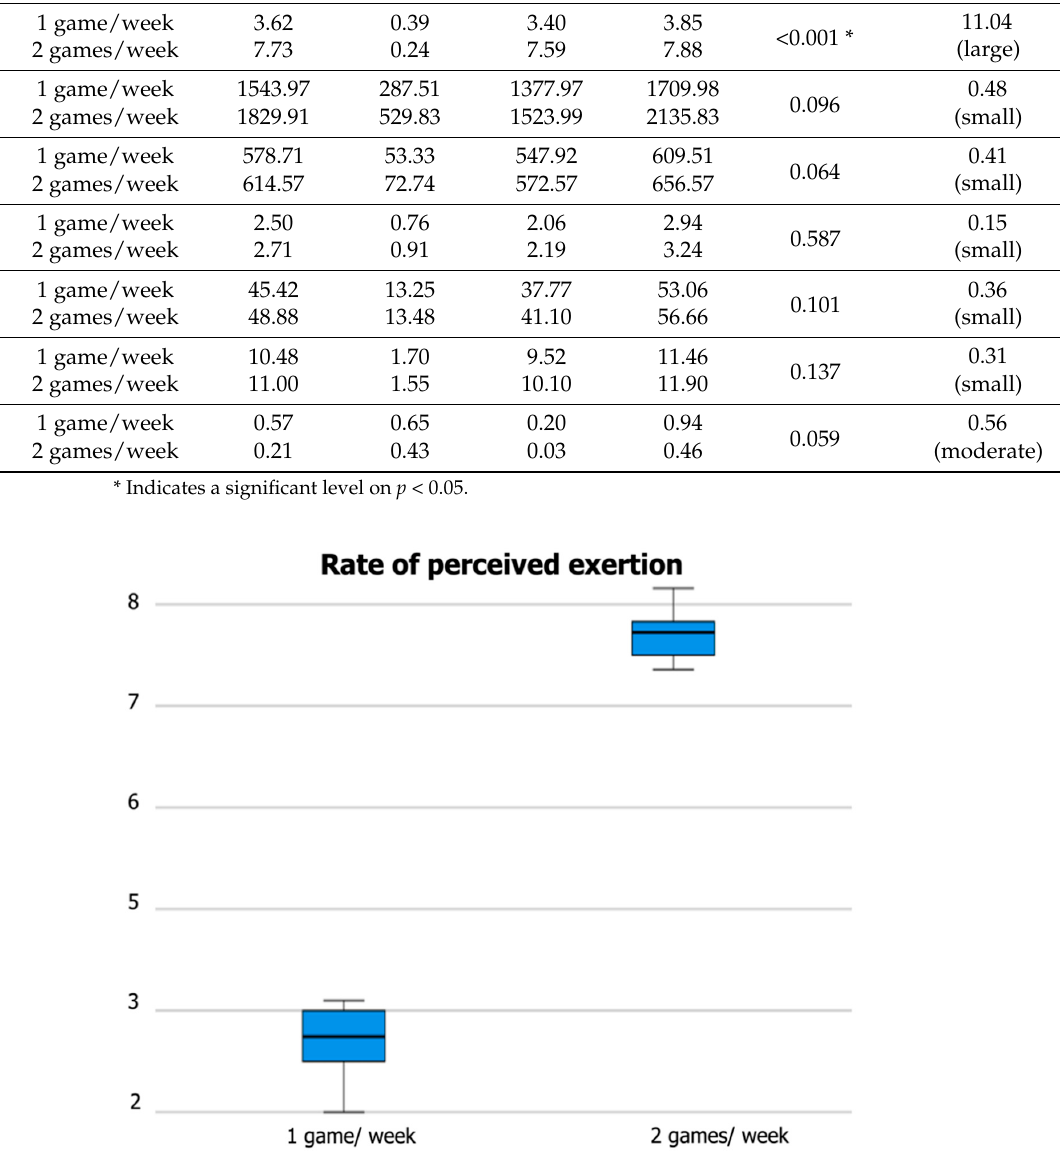
Figure 1. Rate of perceived exertion (RPE)